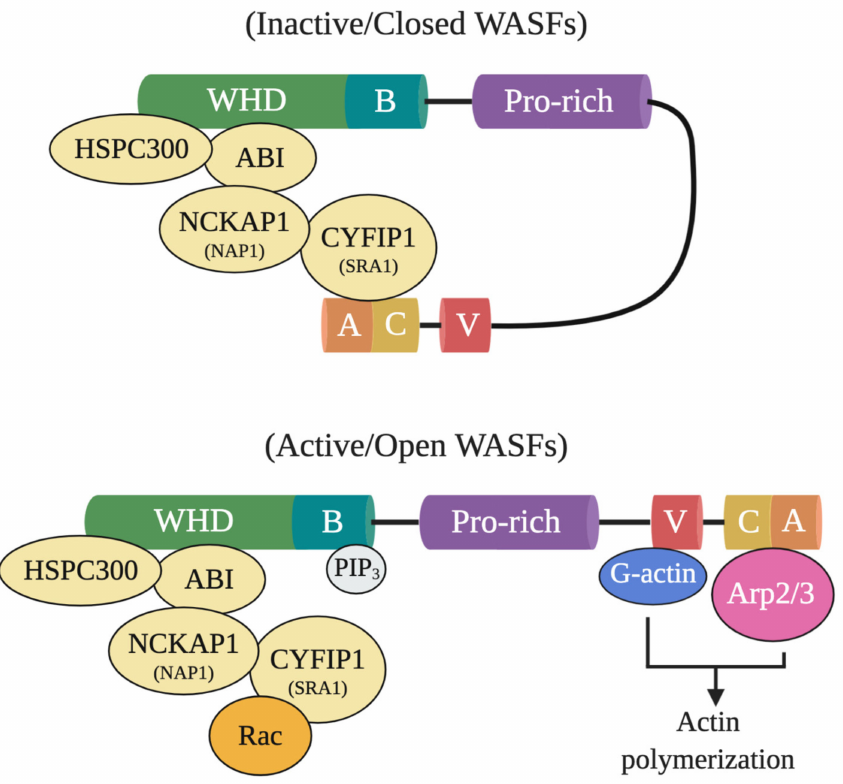
Figure 1. Inactive and active WASF domain confirmations. At resting state, WASFs exist in an autoin- hibited closed conformational state due to the interactions between members of the N -terminally located WASF homology domain (WHD) and the C -terminus. Members of the protein complex at WHD include HSPC300, ABI, NCKAP1 (NAP1), CYFIP1 (SRA1), and WASF1/2/3. Upon activation by Rac, WHD interactions are disrupted and WASFs adopts an open conformation where their verprolin-cofilin-acidic (VCA) region can interact with the actin-related protein (Arp) 2/3 complex and monomeric actin (G-actin). Phosphatidylinositol (3,4,5)-trisphosphate (PIP3) may also recruit the WASF complex to the membrane by binding to the basic domain (B) of